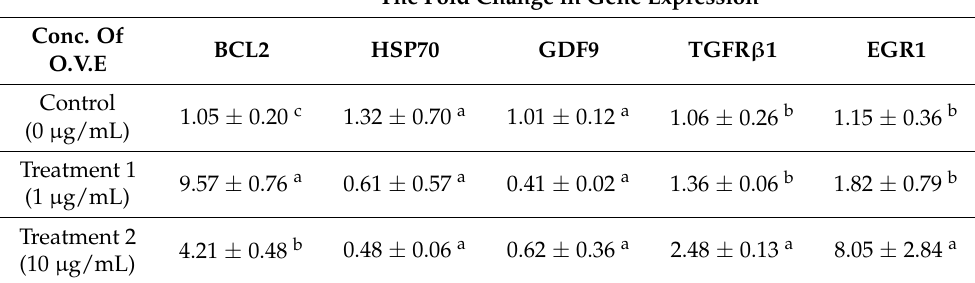
Table 5. The effect of the O. vulgare extract on the gene expression during cleavage of sheep embryos in